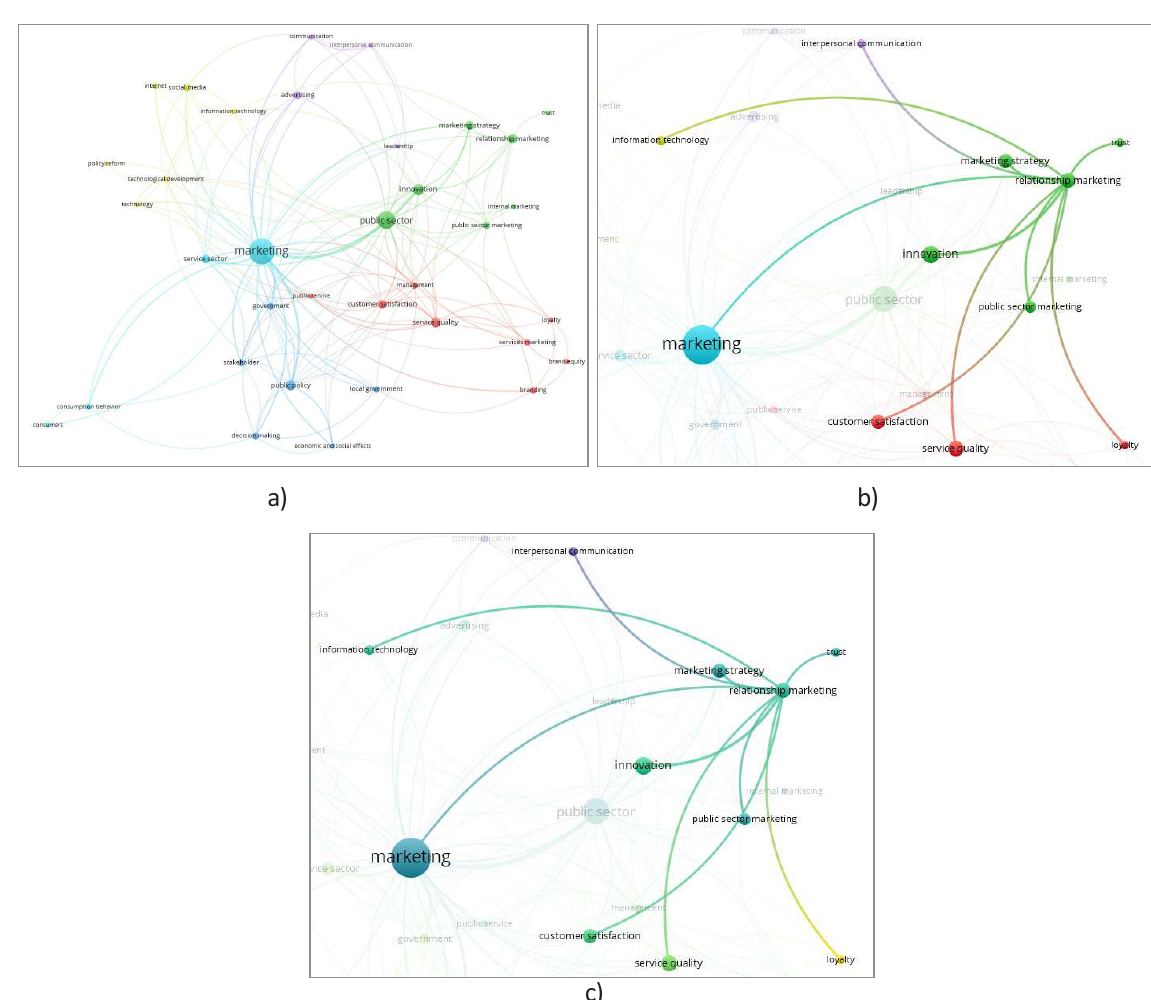
Figure 3. Graphic visualization of research on public service